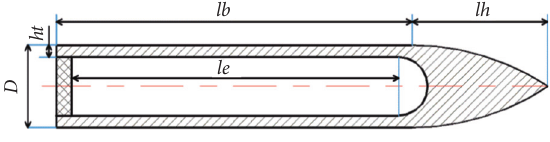
Figure 2: Projectile